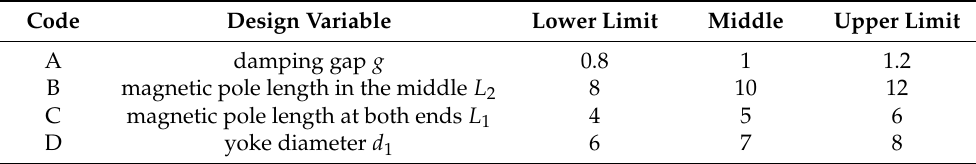
Table 3. Upper and lower limits of design variables of damper structure parameters.